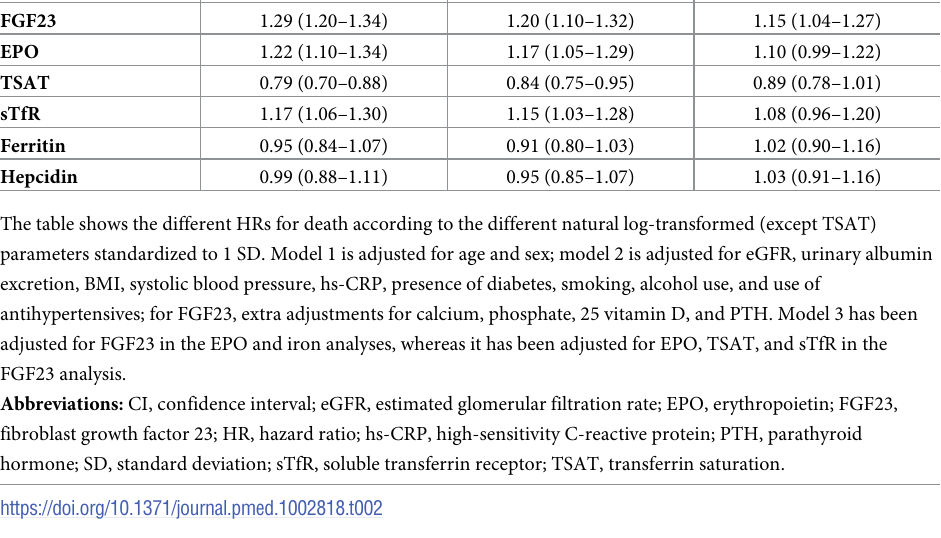
Table 2. HRs (and 95% CIs) for death according to FGF23, iron status parameters, and EPO.